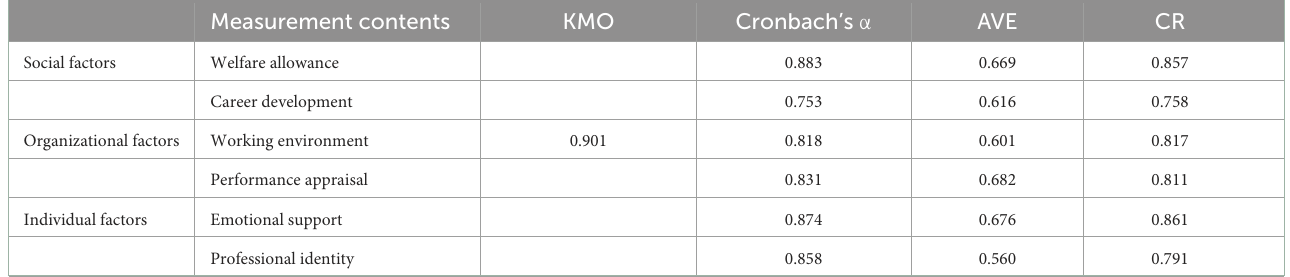
TABLE 3 Testing for reliability and validity.